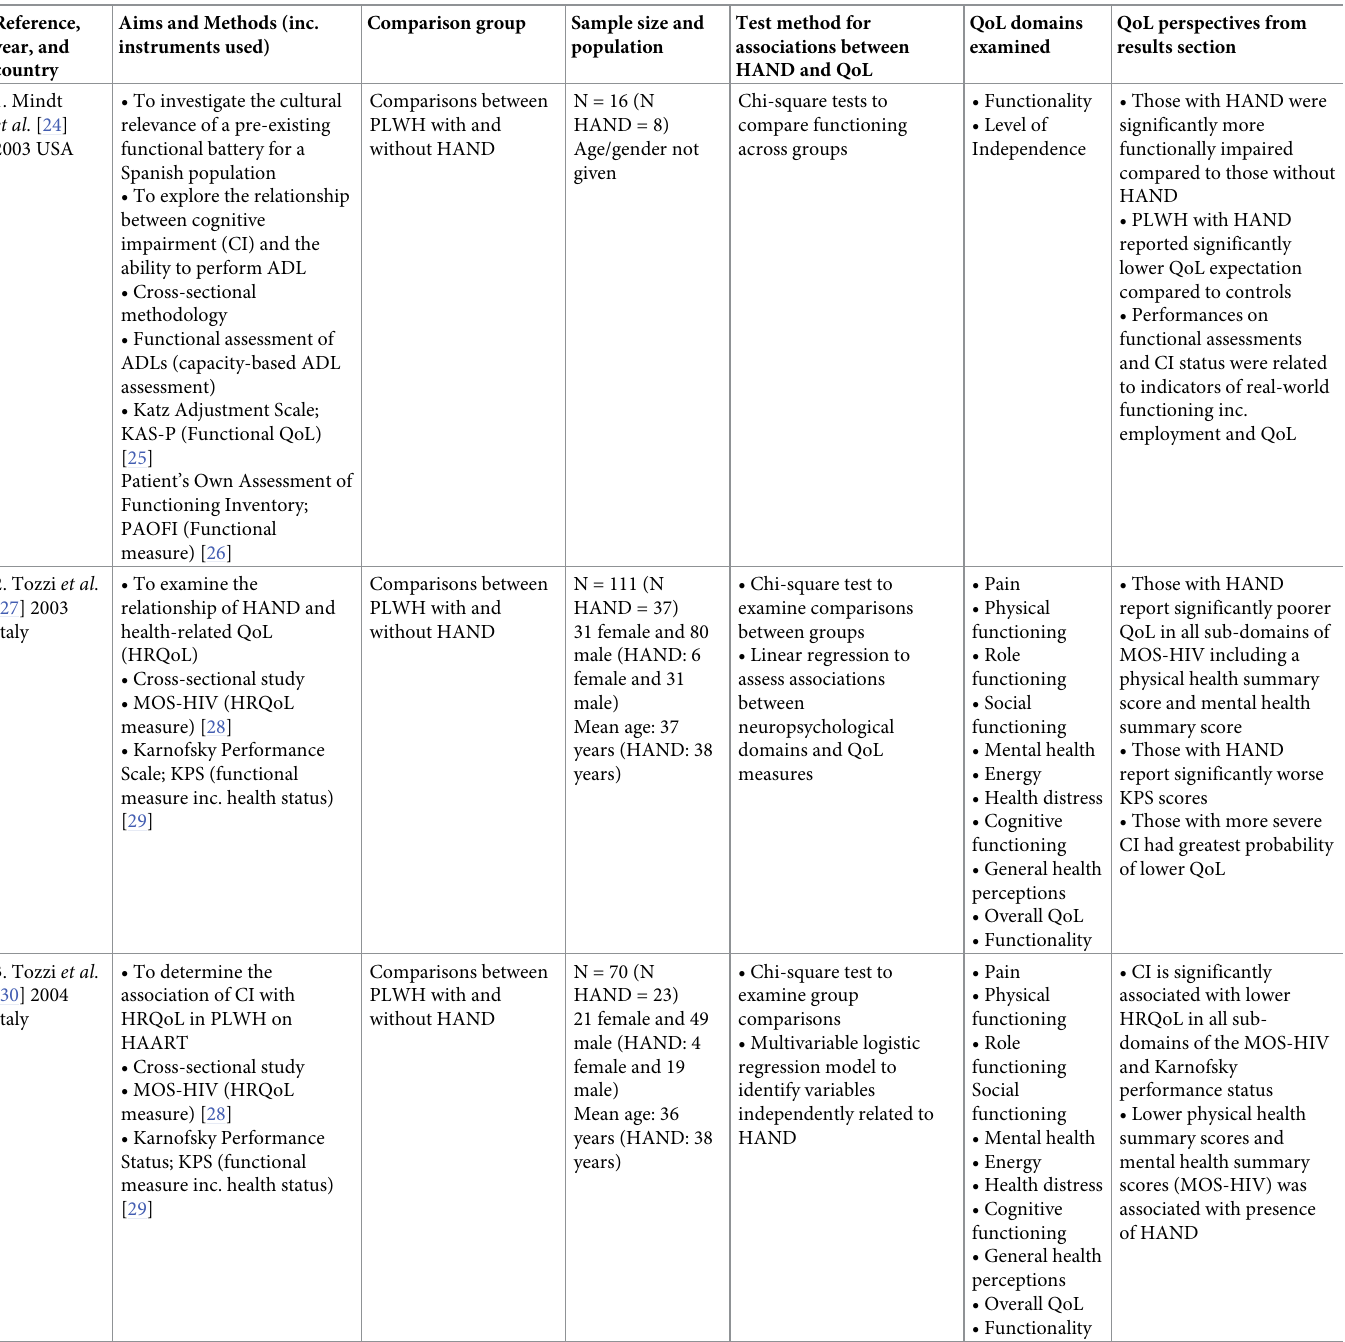
Table 2. Study characteristics and main findings. Reference, year, and